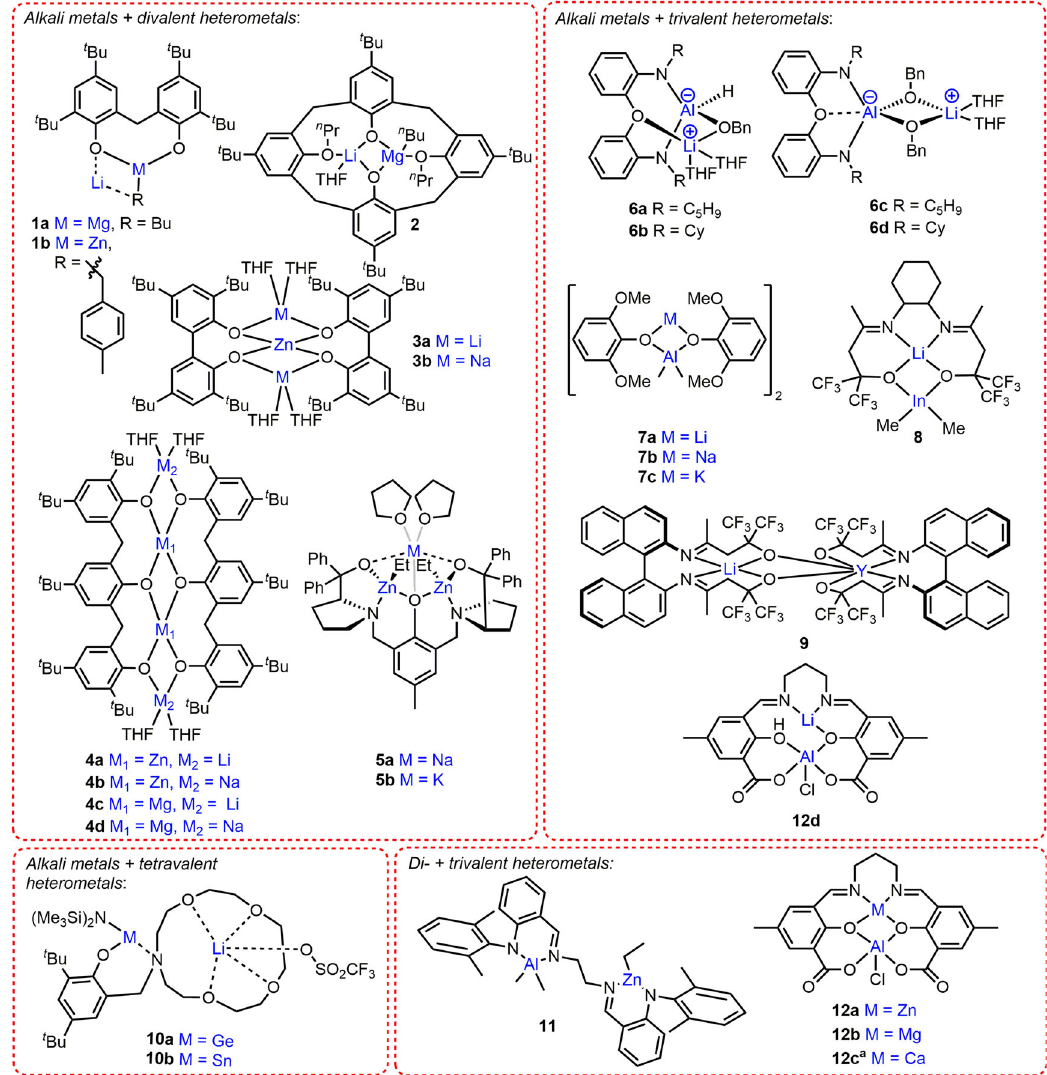
Fig. 2 Main group heterometallic catalysts for cyclic ester ROP. Structural representations of heterometallic complexes reported for cyclic ester ROP, where alkali metals are combined with di-, tri- and tetravalent heterometals and trivalent Al is combined with divalent metals. a In 12c , one Ca bridges two (salen)AlCl complexes with each ligand retaining one phenolic O H